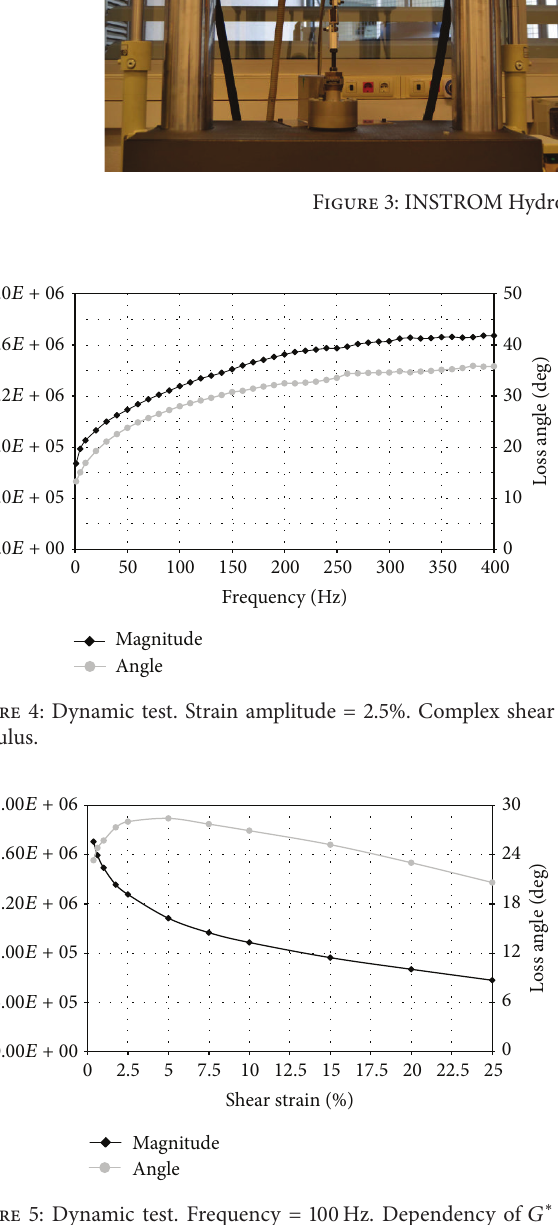
Figure 5: Dynamic test. Frequency = 100Hz. Dependency of 𝐺 ∗ with deformation